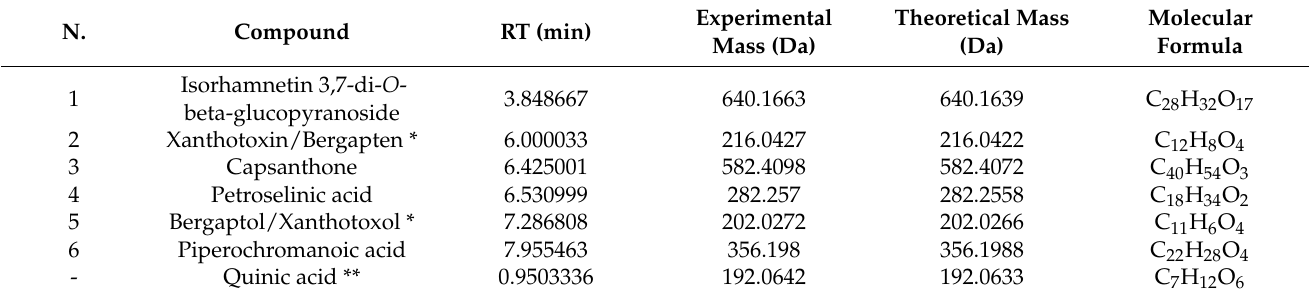
Figure 2. Magnified total ion chromatogram of the extract of T22-treated plants recorded in positive mode. Putatively identified metabolites and the corresponding peak numbers in the figure are reported in Table 1. Table 1. Putatively identified metabolites in parsley extract obtained by LC-MS analysis. Data include peak number as reported in Figure 2, retention time, experimental and theoretical mono-isotopic mass and molecular formula. * Stereoisomers for which it was not possible to make a distinction in the chromatogram. ** Putatively identified molecule from LC-MS analysis performed in negative mode. N.